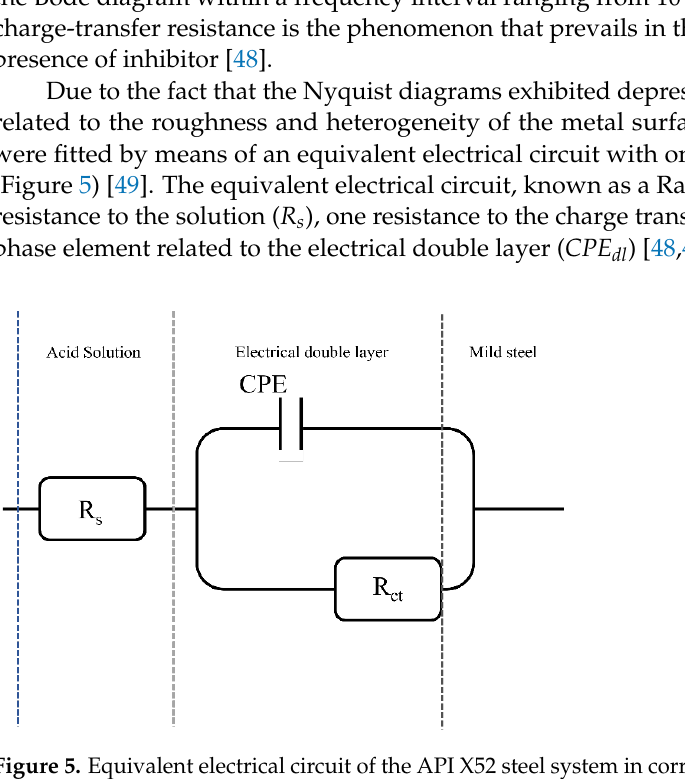
Figure 4. Impedance spectra of API X52 steel in 0.5 M HCl in the absence and presence of [THDA + ][ − AA] at different concentrations: ( a ) Nyquist and ( b ) Bode diagrams.